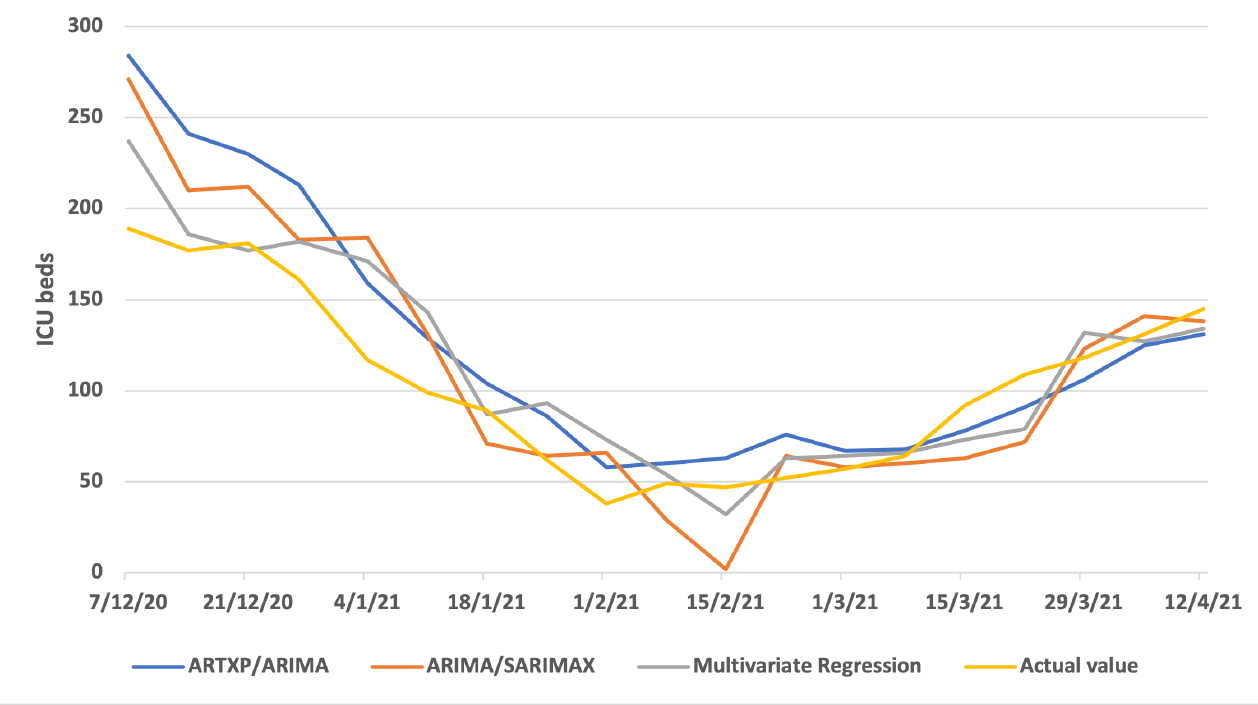
Figure A2. Two weeks Predicted vs. Actual